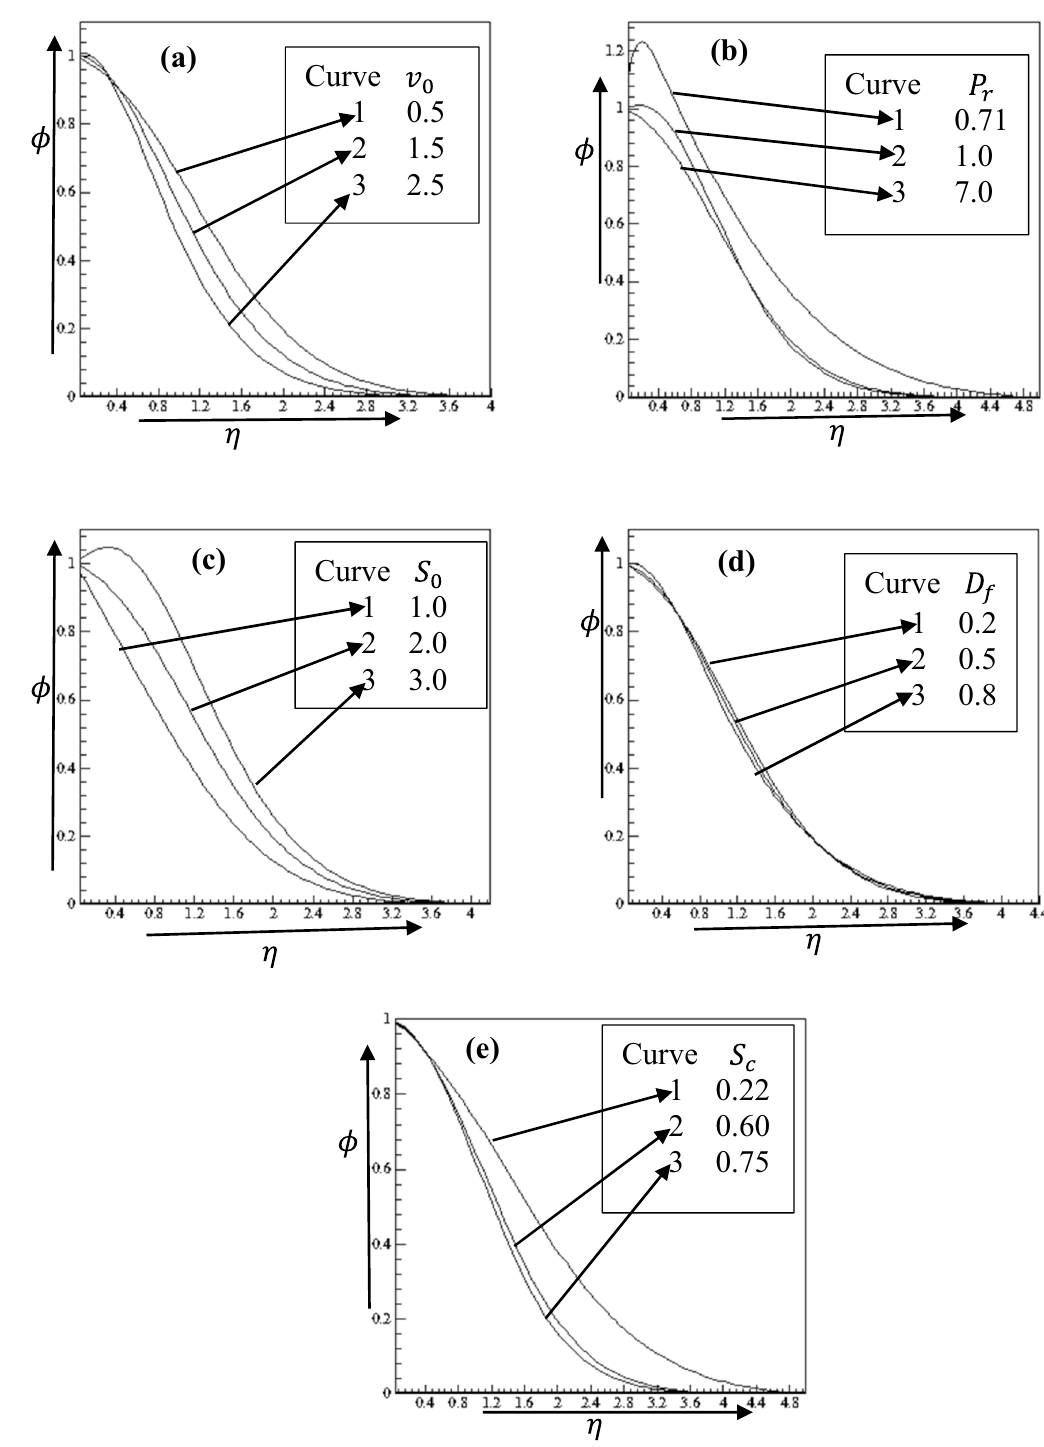
Fig. 4 Concentration profiles for the variation of a v 0 , b P r c S 0 , d D f , and e S